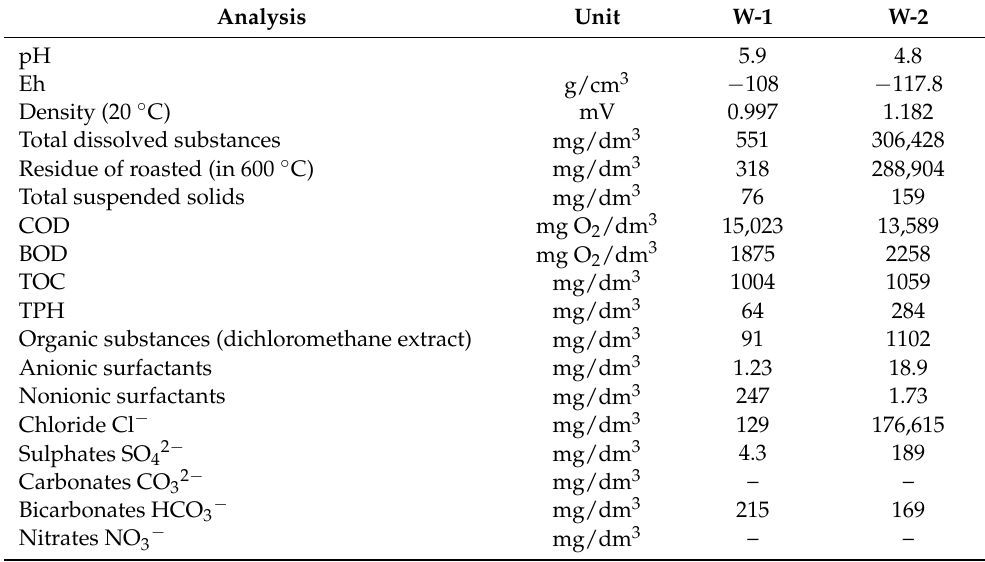
Table 1. Results of physical–chemical analyses of separator water samples W-1 and